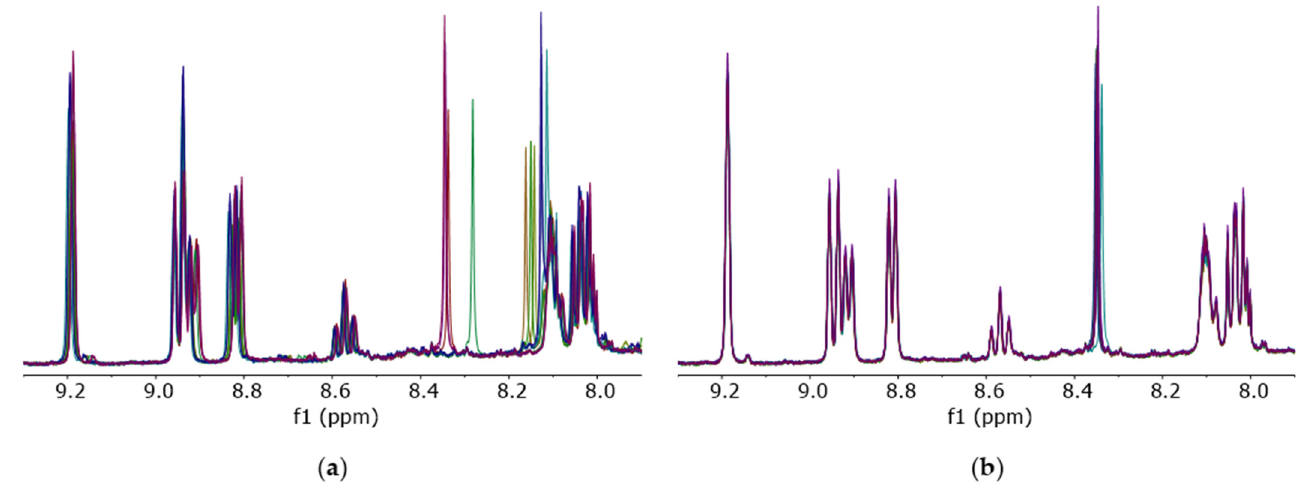
Figure 5. Superposition of ten spectra in the range of δ H = 7.9–9.3 ppm of a fat extract of the same coffee sample. ( a ) Solvent was untreated (D 1 )chloroform and (D 4 )methanol (1/1, v / v ) and ( b ) mitigated (D 1 )chloroform and (D 4 )methanol (1/1, v / v ). 1 H-NMR spectra, 400 MHz, 290 K, referenced to δ TMS = 0.00 ppm. Signal assignments: 9.18 ppm (singlet), 8.95 ppm (doublet), 8.81 ppm (doublet), 8.03 ppm (multiplet) trigonelline; 8.91 ppm (doublet), 8.57 ppm (triplet), 8.10 ppm (multiplet, broad) N -methylpyridinium; 8.34 ppm (singlet) formic acid.